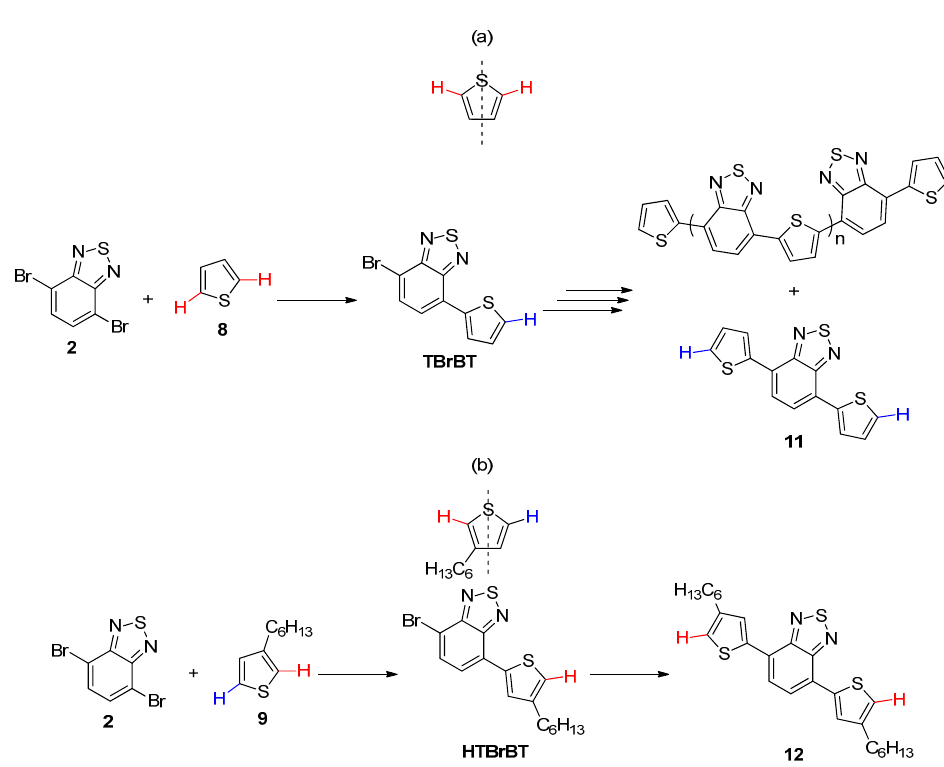
Figure 3. Possible reaction pathways and side reactions in the formation of monomers 11 and 12 through DHA protocols. TBrBT: 4-thiophene-7-bromo-2,1.3-benzothiadiazole; HTBrBT: 4-(3-hexylthiophene)-7-bromo-2,1.3-benzothiadiazole; ( a ) intermolecular DHA for monomer 11 ; ( b ) intermolecular DHA for monomer 12.